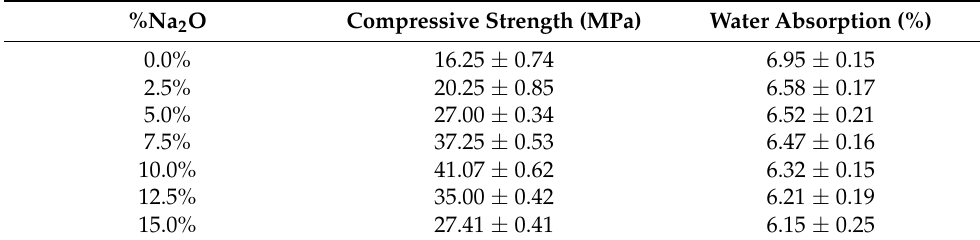
Table 4. Properties of mortars.